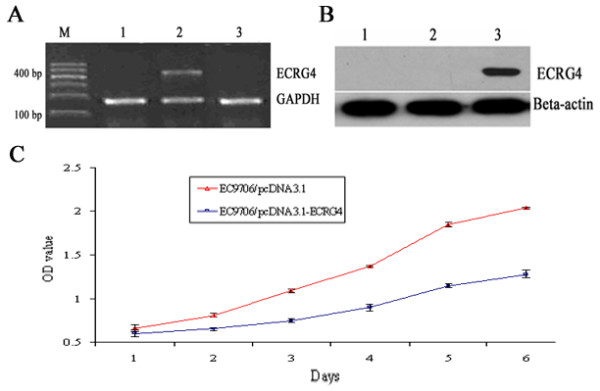
Evaluation of ECRG4 gene expression and cell growth curve of EC9706/pcDNA3.1 and EC9706/pcDNA3.1-ECRG4. (A) ECRG4 mRNA was detected in EC9706/pcDNA3.1-ECRG4 cells by RT-PCR. M: Marker; Lane 1: EC9706/pcDNA3.1; Lane 2: EC9706/pcDNA3.1-ECRG4; Lane 3: EC9706 cells. (B) ECRG4 protein (17 KD) was detected in EC9706/pcDNA3.1-ECRG4 cells by Western blot. Lane 1: EC9706 cells; Lane 2: EC9706/pcDNA3.1; Lane 3: EC9706/pcDNA3.1-ECRG4. (C) Cell growth curve of EC9706/pcDNA3.1 and EC9706/pcDNA3.1-ECRG4 by MTT assay (P < 0.05).